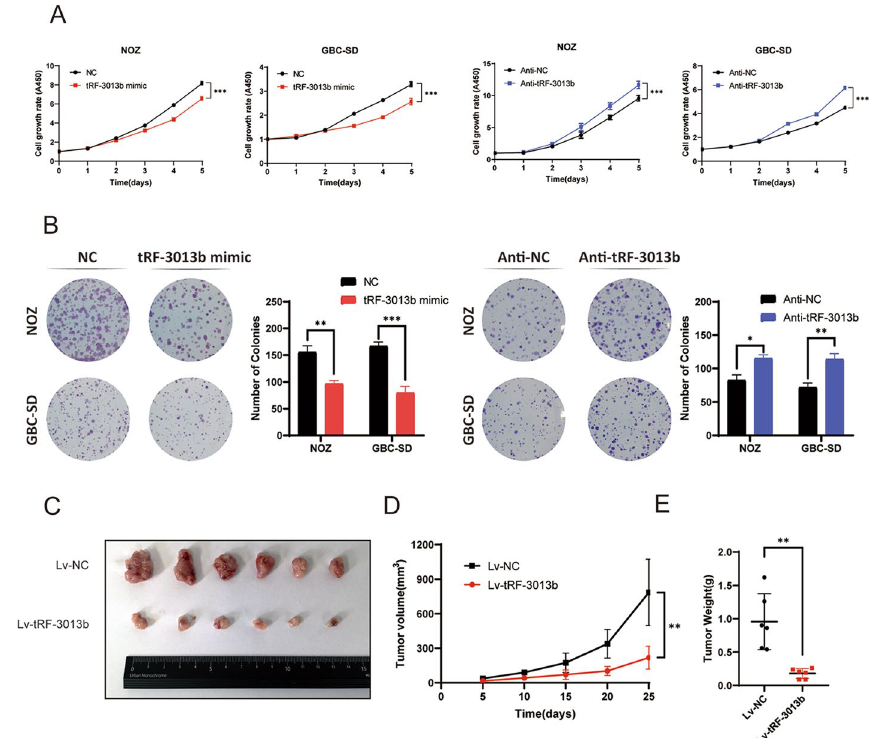
Fig. 3 tRF-3013b inhibited GBC cell proliferation. A CCK8 assay and B colony formation were performed